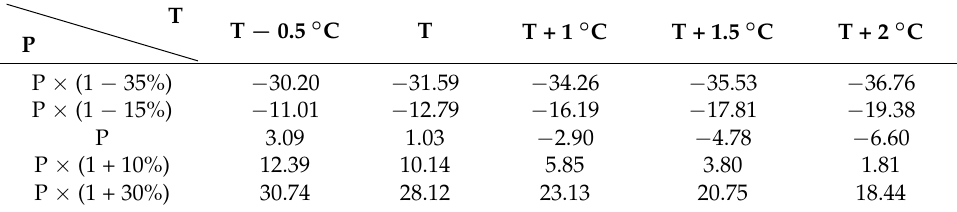
Table 4. The rate of runoff change during the flood season in the study area under future scenarios.